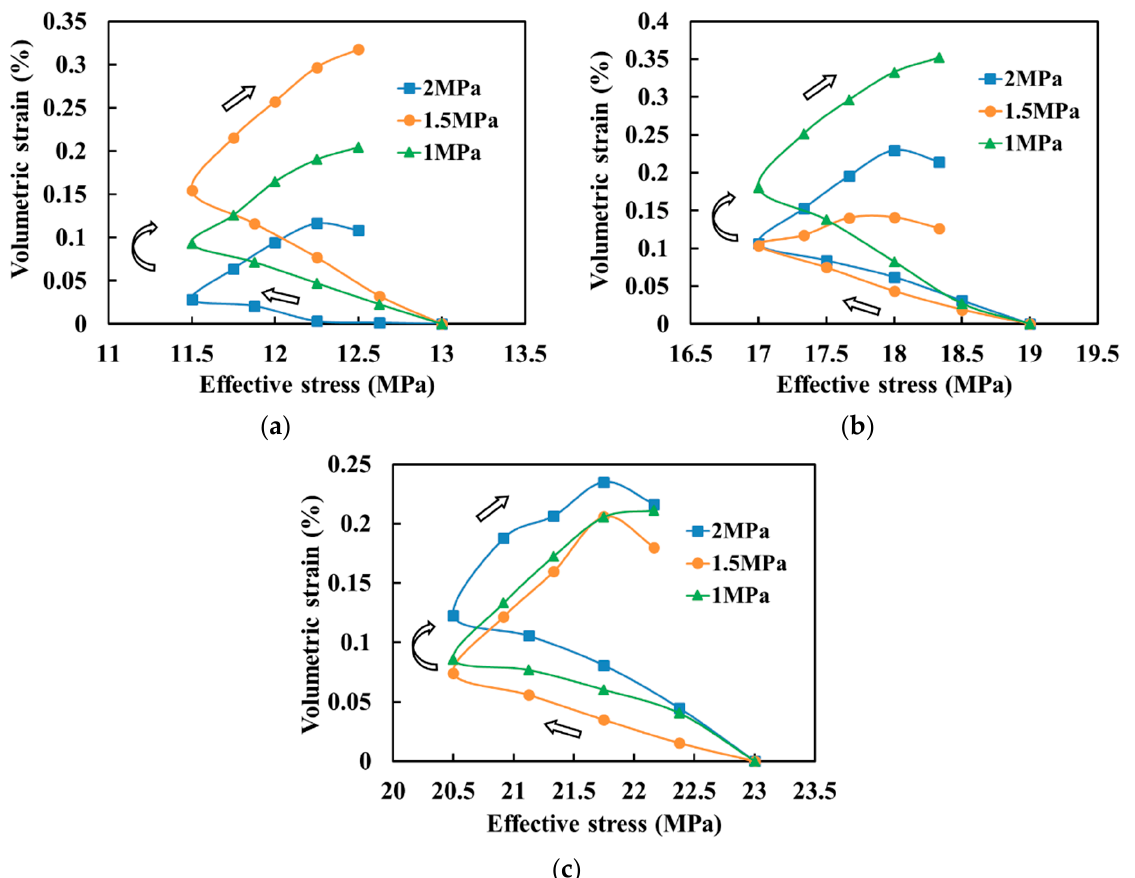
Figure 6. Volumetric strain variation of sandstone under different initial confining pressures (( a – c ) are the initial confining pressure of 15 MPa, 20 MPa, and 25 MPa, respectively).